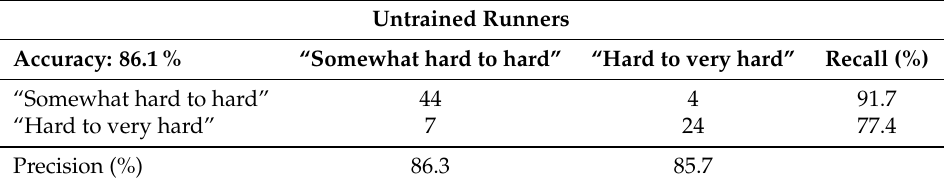
Table 5. Confusion matrix for the CNN classifiers in the recreational runner setting. Each row represents the correct label (e.g., ground truth), whereas the columns display the predictions made by the network. Untrained Runners Accuracy: 86.1% “Somewhat hard to hard” “Hard to very hard” Recall (%) “Somewhat hard to hard” 44 4 91.7 “Hard to very hard” 7 24 77.4 Precision (%) 86.3 85.7